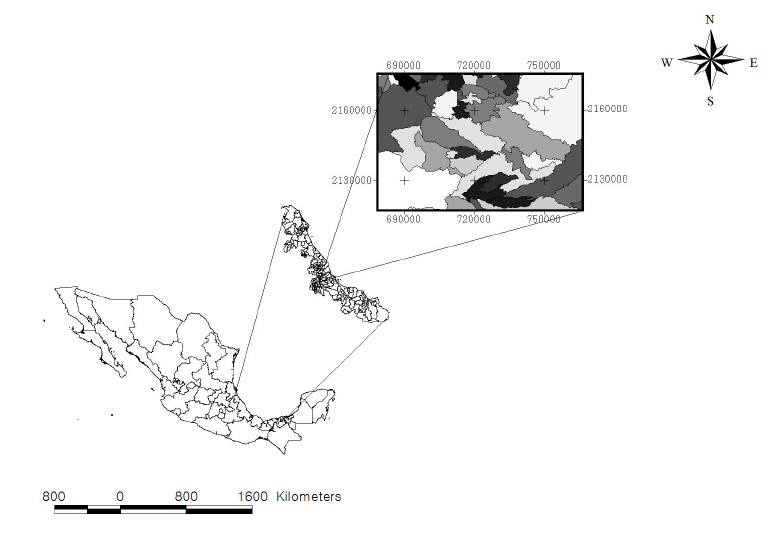
Figure 1. Location of the study site in the central region of the state of Veracruz, México.